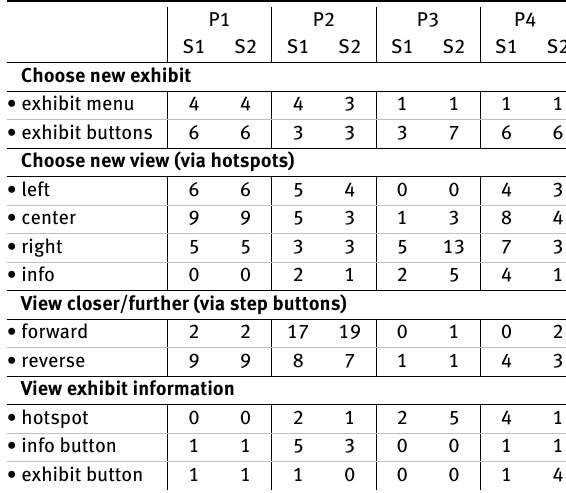
Table 5. Frequency count of the participants selecting user interface elements during their two in-robot